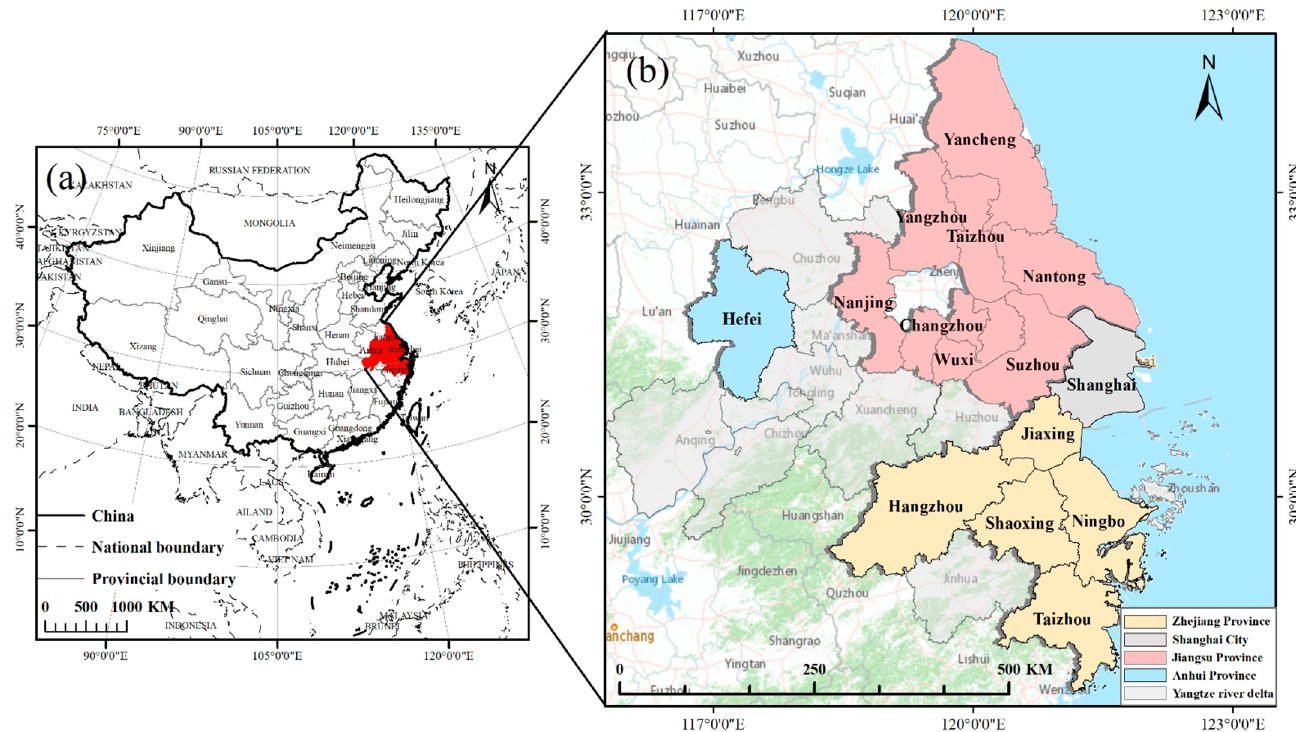
Figure 2. Location of the study area. ( a ) China; ( b ) study area in Yangtze River Delta urban agglom- eration.